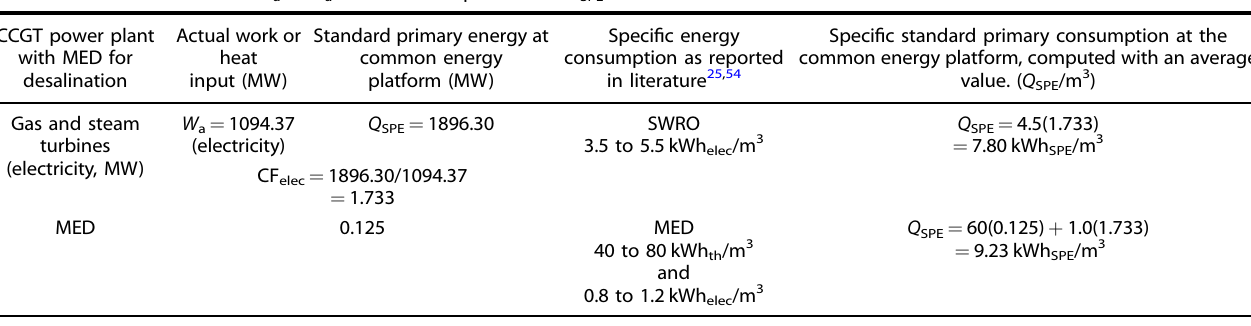
Table 2. The conversion from W a or Q a to a common platform of Q SPE .